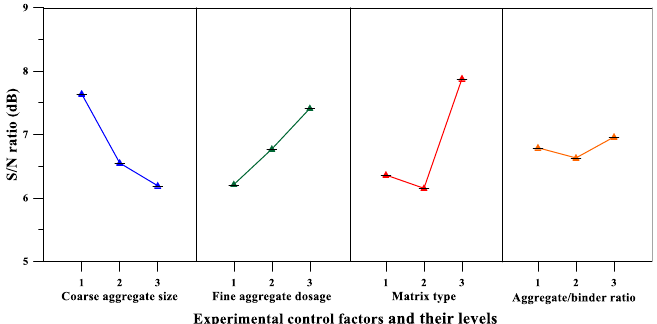
Figure 13. S / N response graph showing the flexural strength of pervious concretes.